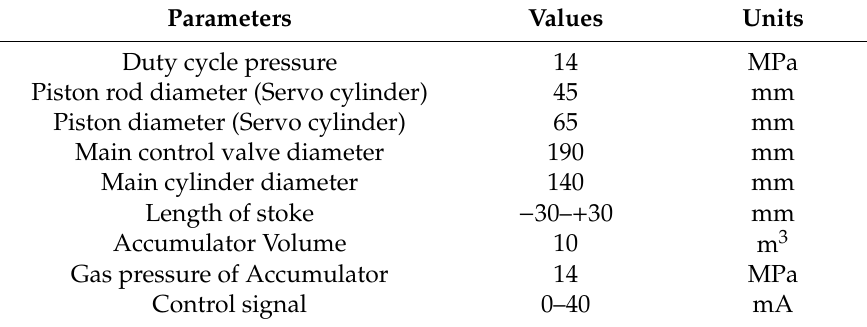
Figure 10. Response characteristics of the electrohydraulic servo all-hydraulic forging hammer.